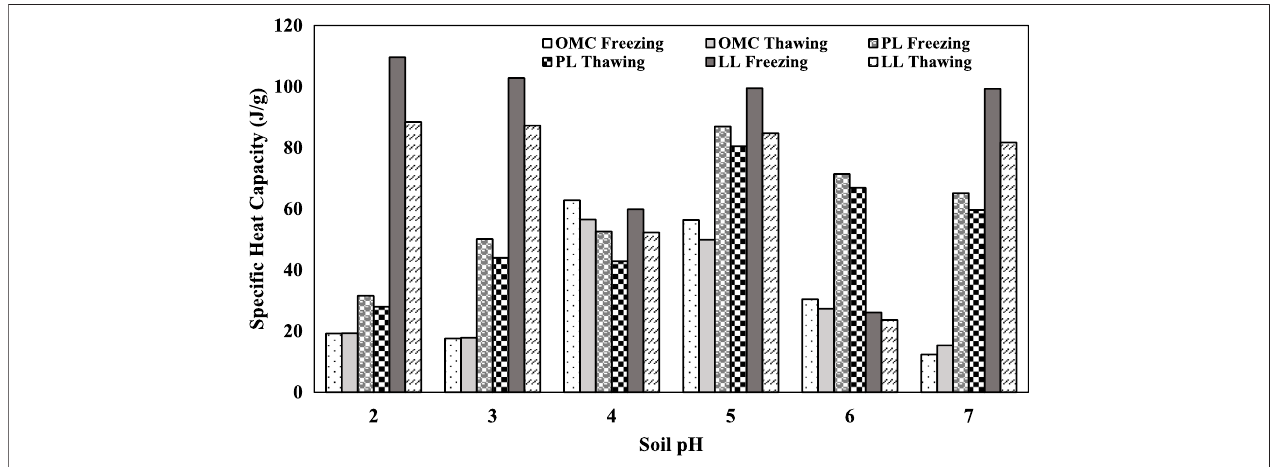
FIGURE 9 | In fl uence of fi ne content on freezing characteristics of plastic and non-plastic soils: (A) freezing point; (B) thawing point; (C) thermal hysteresis.